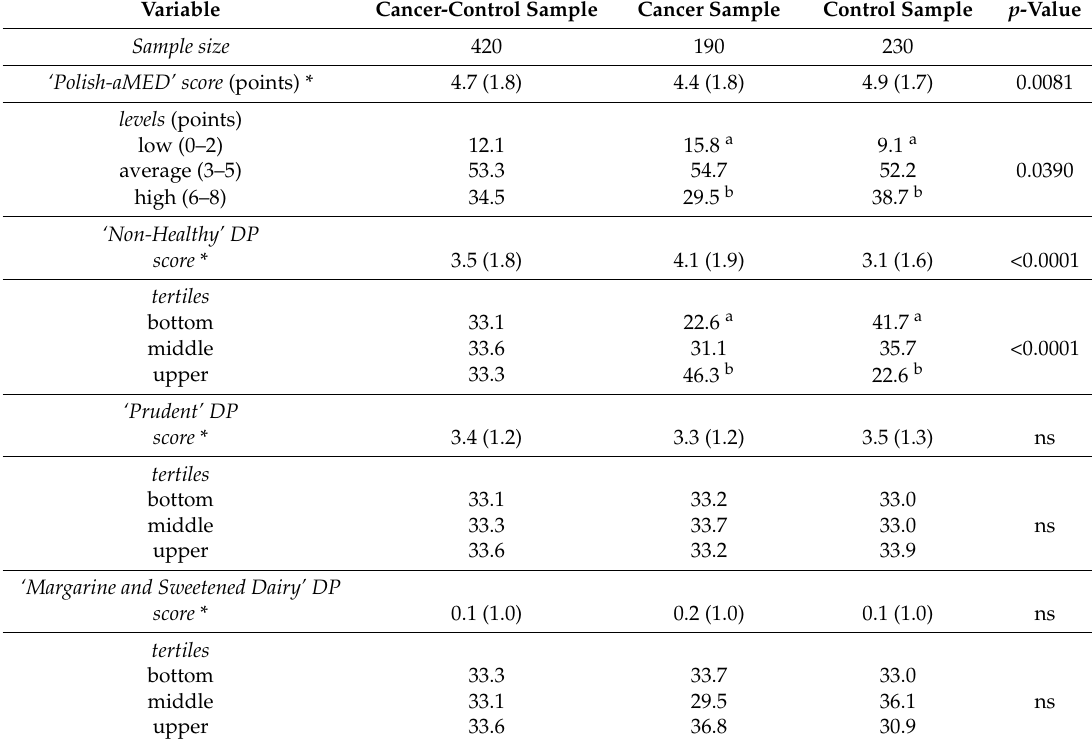
Table 5. ‘Polish-aMED’ score, Principal Component Analysis (PCA)-derived dietary patterns and metabolic-hormone profiles and their components in association with breast cancer